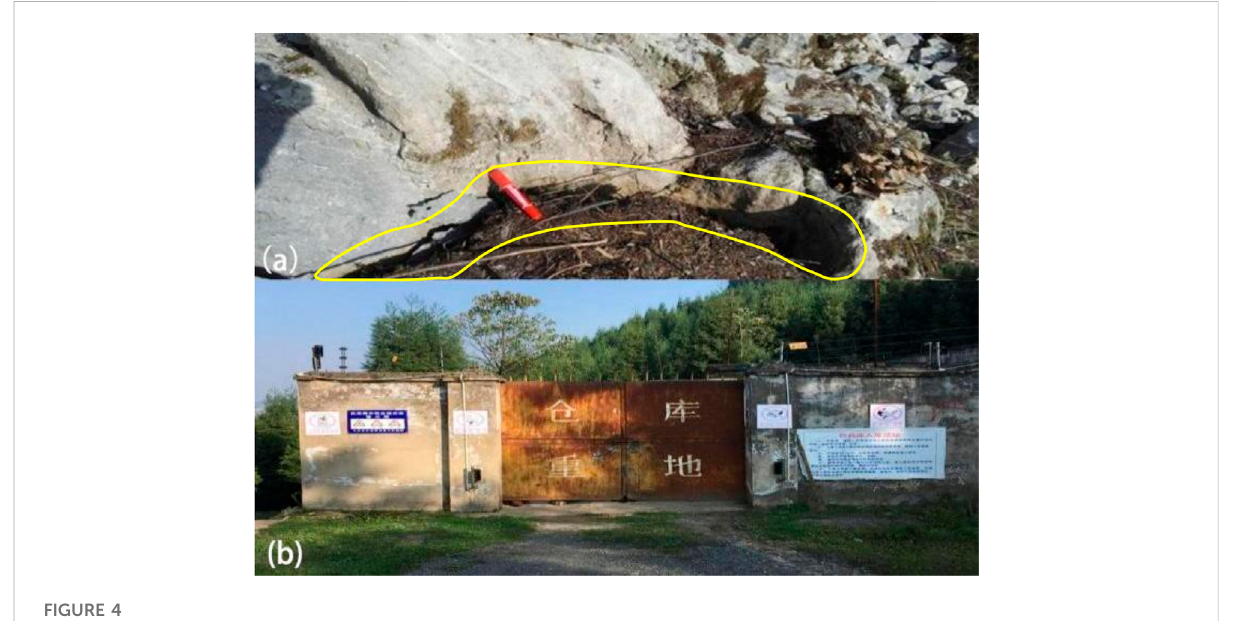
FIGURE 4 Field check photos of